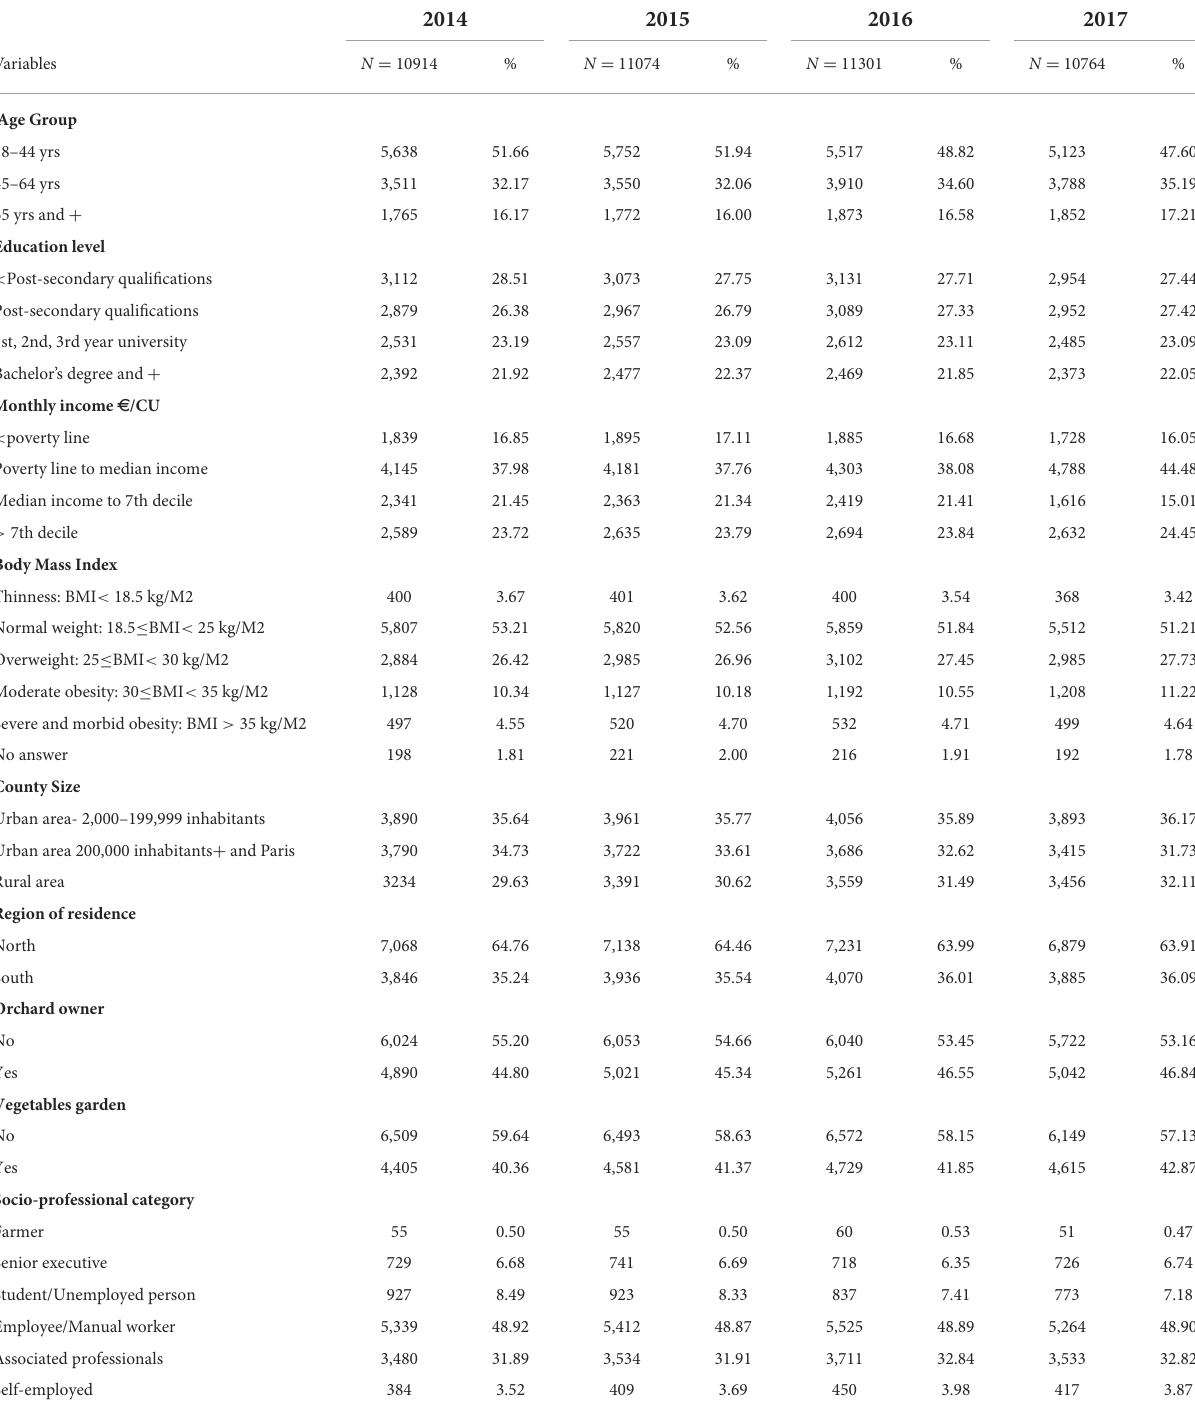
TABLE 1 Descriptive characteristics of the study